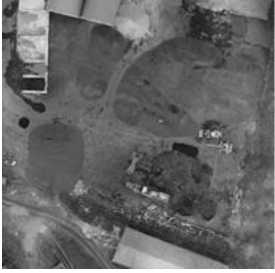
Once the three individual greyscale representations are created based on the original true color and elevation information, those 2D arrays are stacked along a third “channel- dimension” to create a new multi-channel array. For the prototypical implementation of the demonstrator we chose a combination of (1) a greyscale view of the RGB channels, (2) the height map with adjusted relative heights to increase the contrast, and (3) a greyscale representation of the local slope (see Figure 10).